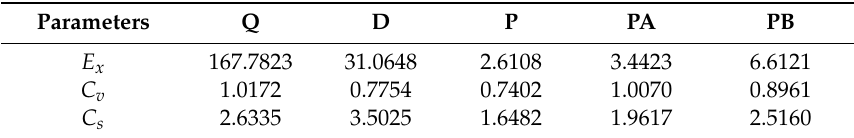
Table 7. Statistical parameters.